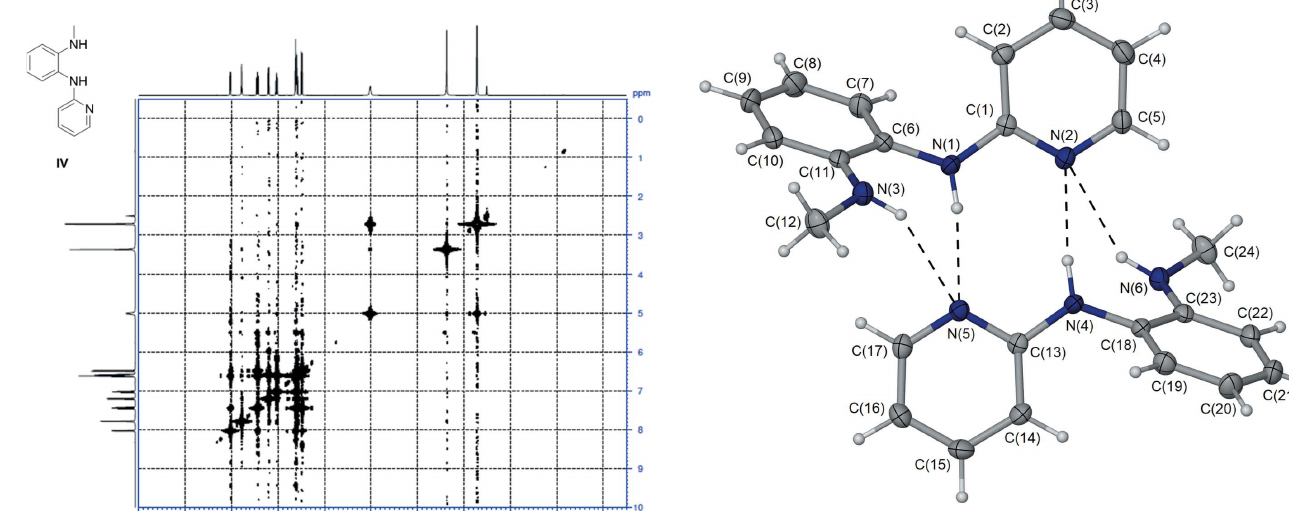
Figure 2 Molecular diagram of the title compound, with non-hydrogen atoms represented by 50% displacement ellipsoids and hydrogen atoms as spheres of arbitrary size.